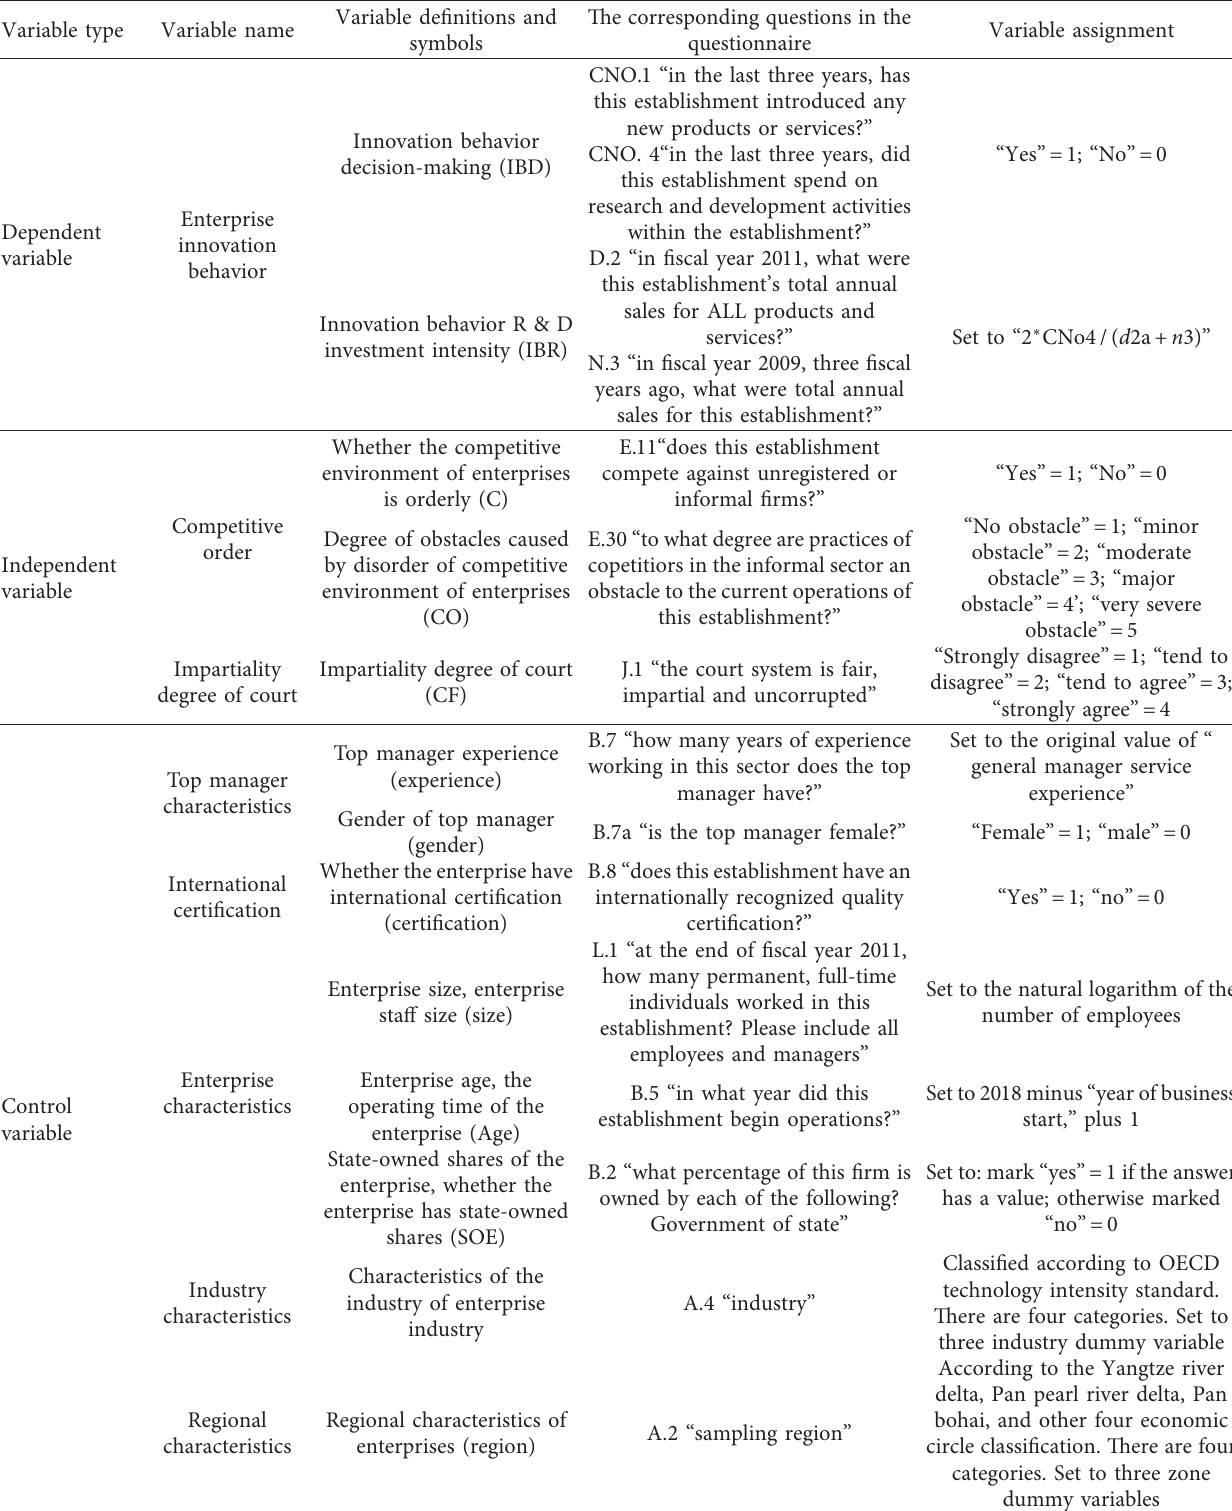
Table 1: Variable design and